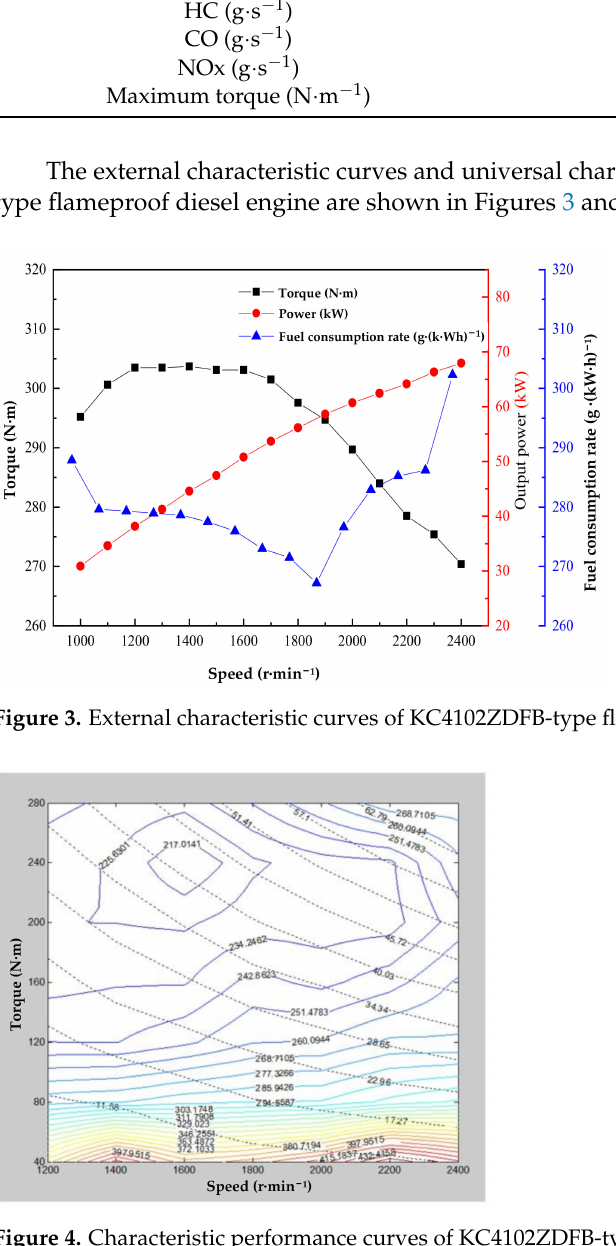
Figure 4. Characteristic performance curves of KC4102ZDFB-type flameproof diesel